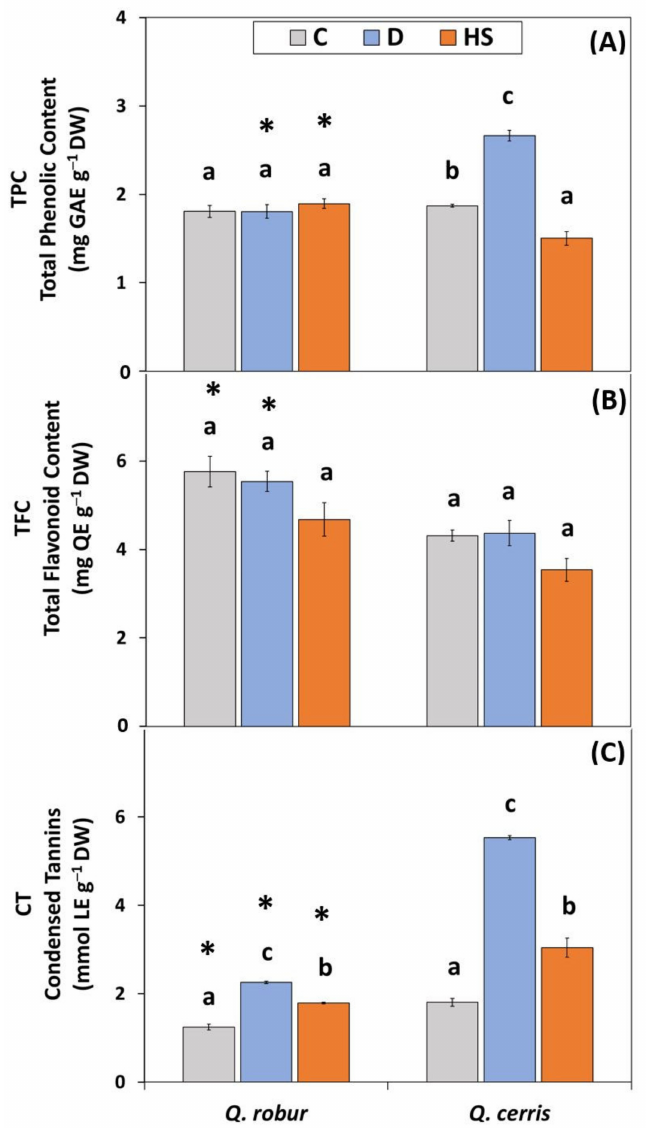
Figure 4. ( A ) Total phenolic content (TPC; mg GAE g − 1 DW); ( B ) total flavonoid content (TFC; mg QE g − 1 DW); and ( C ) condensed tannins (CT; mg LE g − 1 DW) in leaves of Q. robur and Q. cerris